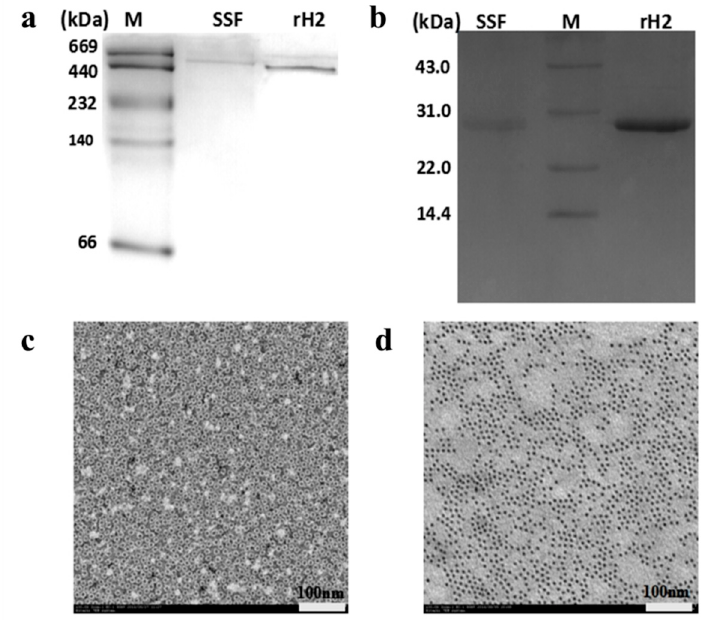
Figure 2. ( a ) Native PAGE analyses and ( b ) SDS-PAGE of soybean seed ferritin (SSF) and recombinant H2 ferritin (rH-2); ( c ) TEM picture of purified rH-2 after beingnegatively stained by 2% uranyl acetate; ( d ) TEM picture of holo soybean seed ferritin (SSF) without negative staining of uranyl